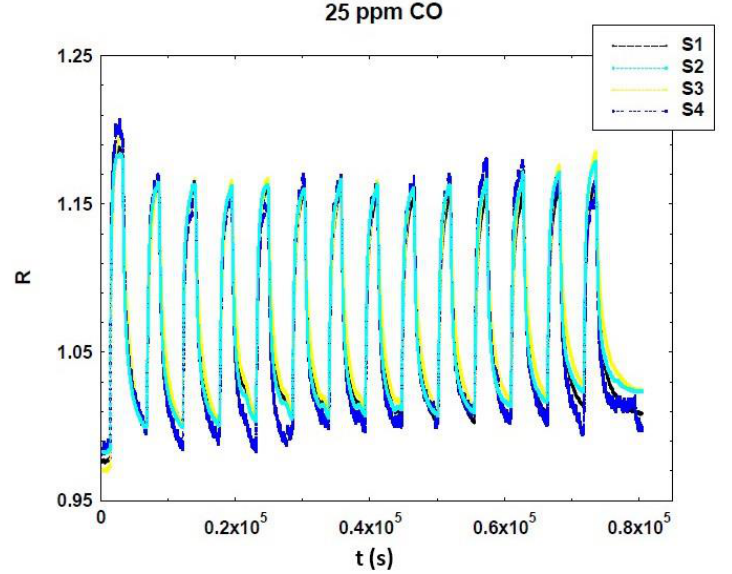
Figure 7. Normalized dynamic responses of SmFeO 3 sensors vs. 25 ppm of CO, at a working ◦ temperature of 350°C. temperature of 350